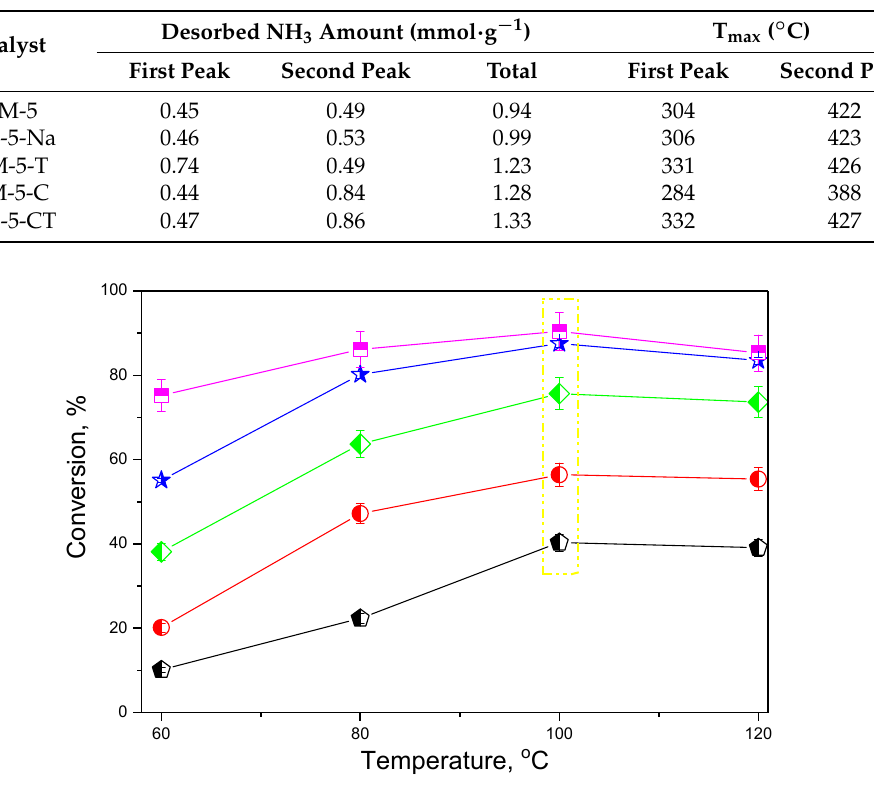
Table 4. Determination of total acidity of untreated and treated zeolites using NH 3 -TPD analysis.